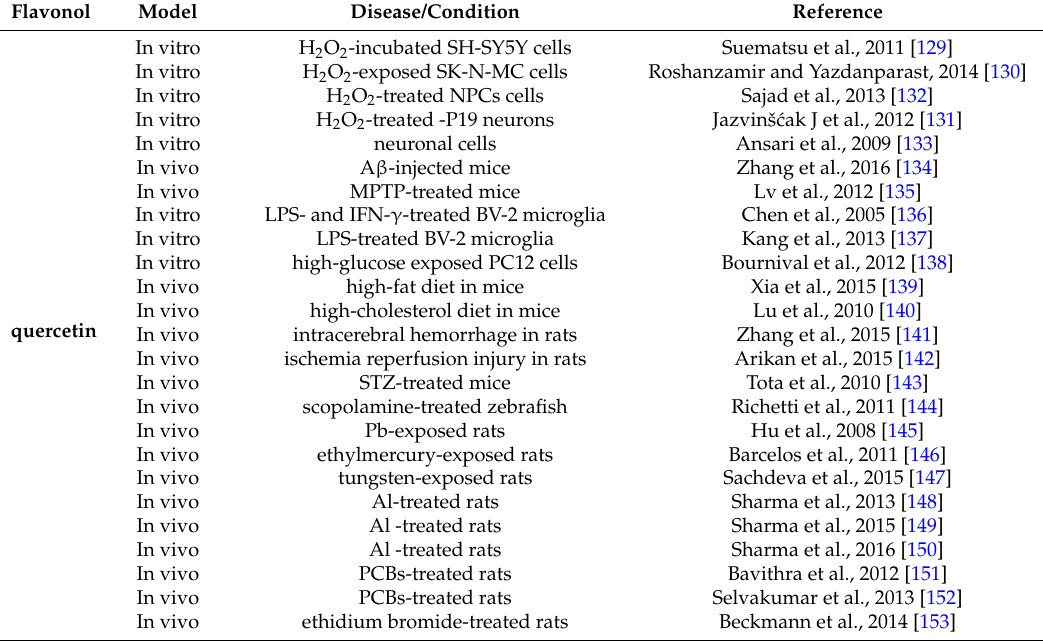
Table 4. Studies employed quercetin in experimental models of